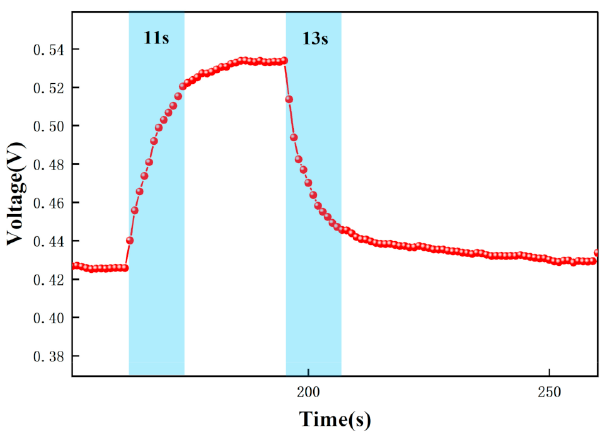
Figure 20. Response recovery time for testing at 1.8 ppm